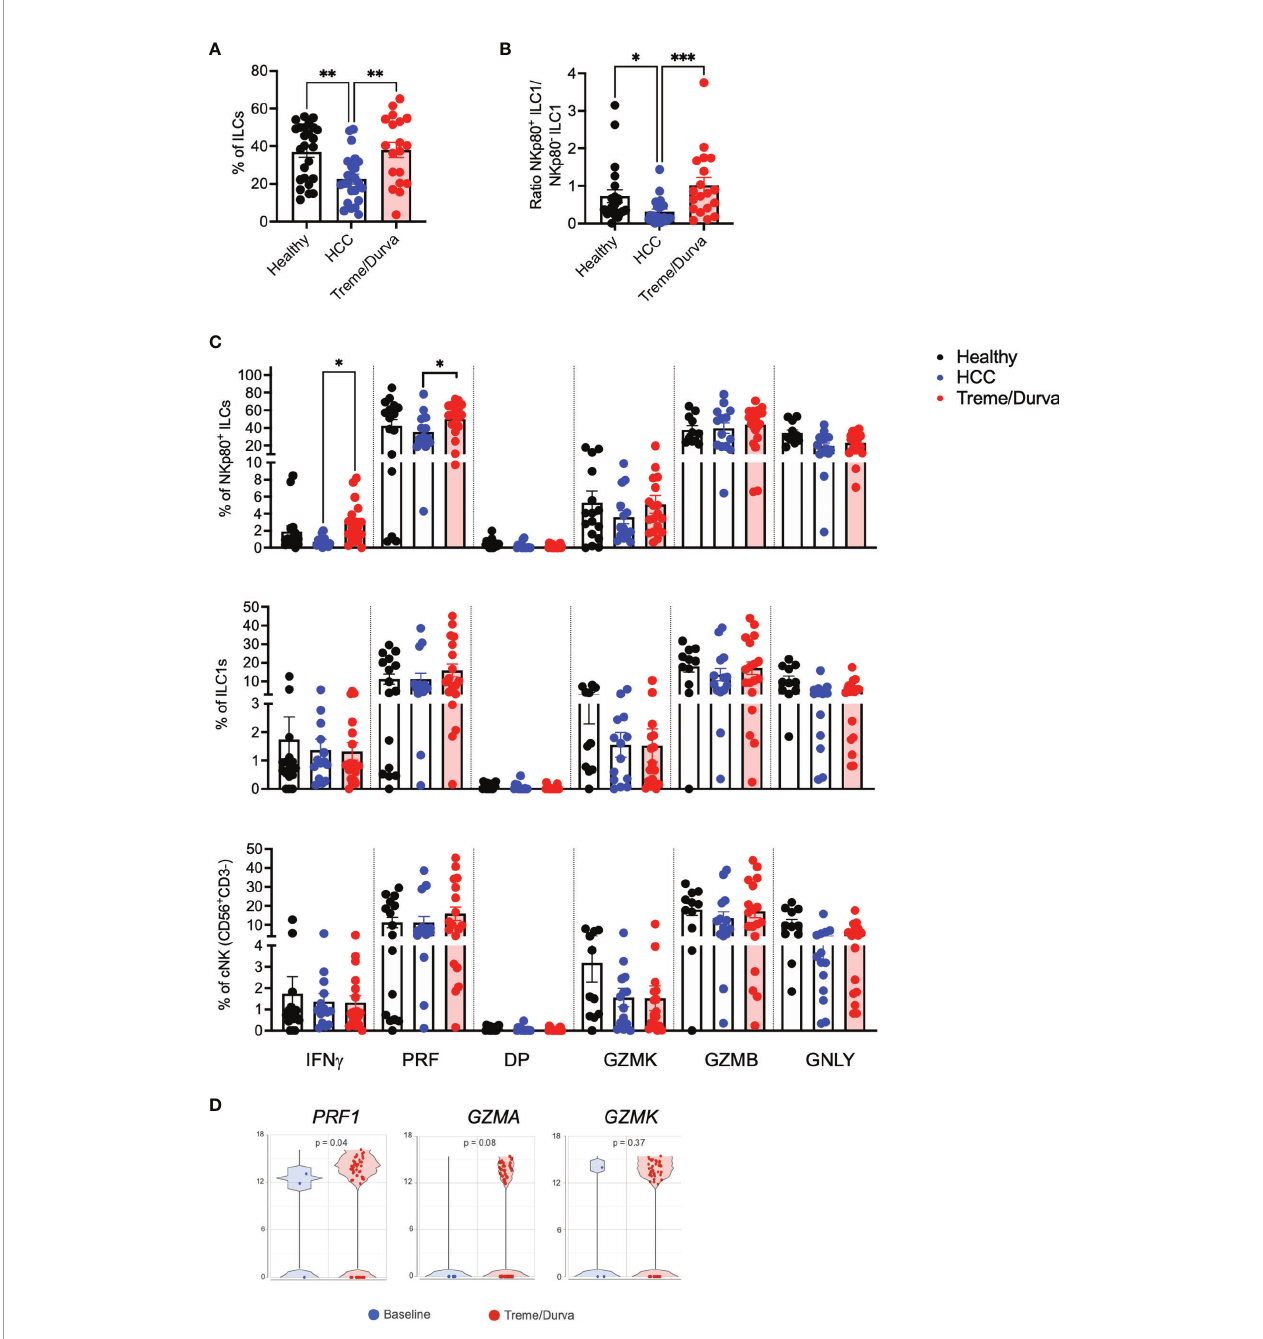
FIGURE 3 | (A) Boxplot showing frequencies of NKp80 + CD56 + ILCs of all ILCs in PBMCs of healthy donors (n = 25), patients with HCC (n = 24), or HCC patients after up to four cycles of combined ICI therapy (treme/durva; n = 20)). (B) Boxplot showing ratio of NKp80 + ILC1s to NKp80 - ILC1s in PBMCs of indicated cohorts. (C) Frequency of IFN g , Perforin (PRF), IFN g and Perforin double positive (DP) and Granzyme K (GZMK), Granzyme B (GZMB) and Granulysin (GNLY) positive cells after stimulation with PMA/Ionomycin for 4h. Cytokine expression comparing NKp80 + NK-like cells with ILC1s and conventional NK (cNK) NK cells de fi ned as CD3 - CD56 + CD94 + cells. (D) Volcano plot showing expression of PRF1 , GZMA and GZMK in cells of HCC patients at baseline and after ICI (Treme/Durva). Signi fi cance: *=p < 0.05, **=p < 0.01, ***=p <